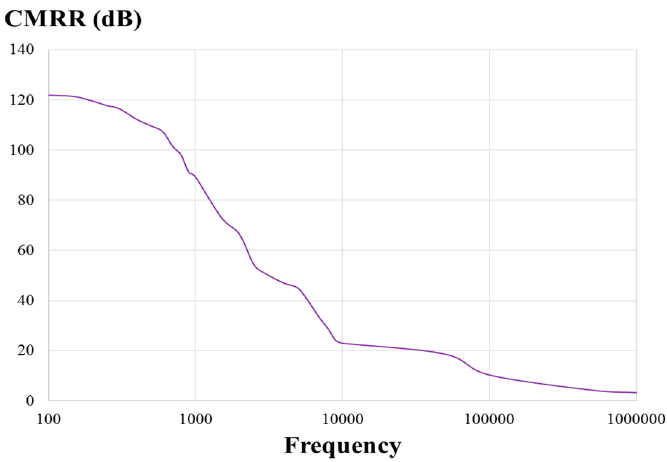
Figure 9. Measured common-mode rejection ratio (CMRR) of the designed opamp.